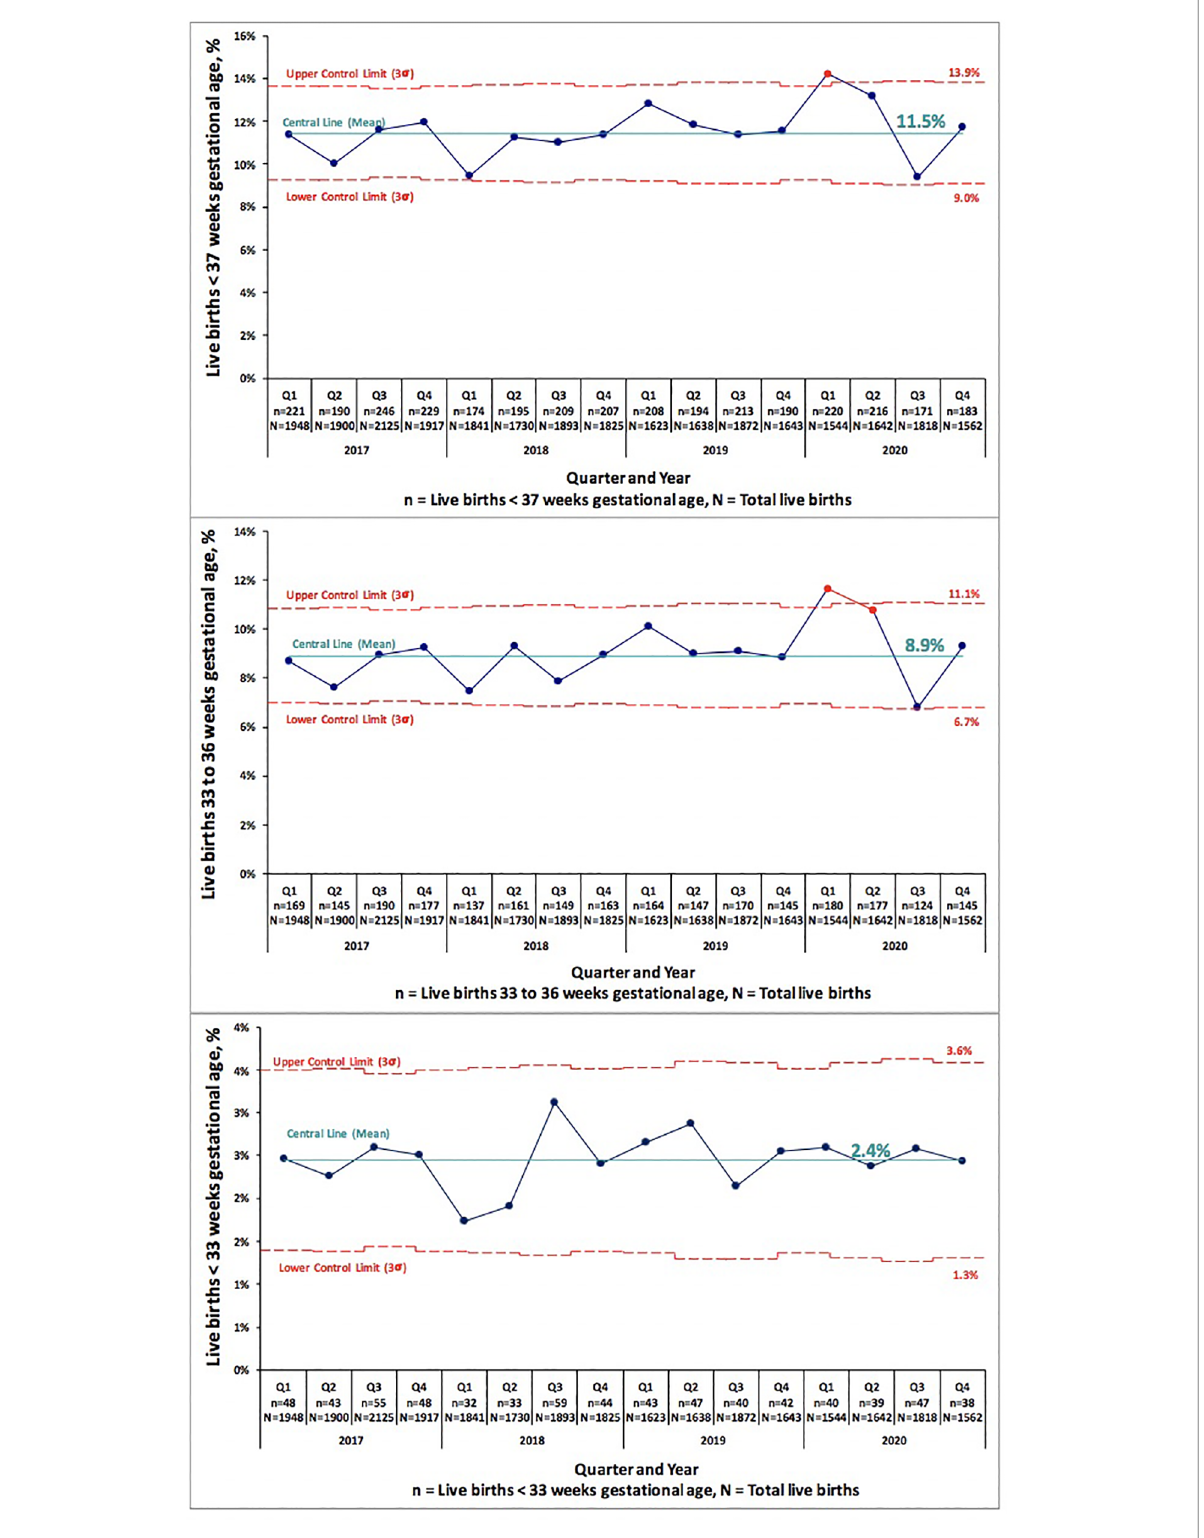
FIGURE 2 Pre-COVID-19 era (2017 – 2019) and COVID-19 era (2020) birth rates across fi ve medical centers strati fi ed by birth weight shown as statistical process control “ p ” chart. The central line represents mean and the upper and lower control limit lines are three standard deviations above and below